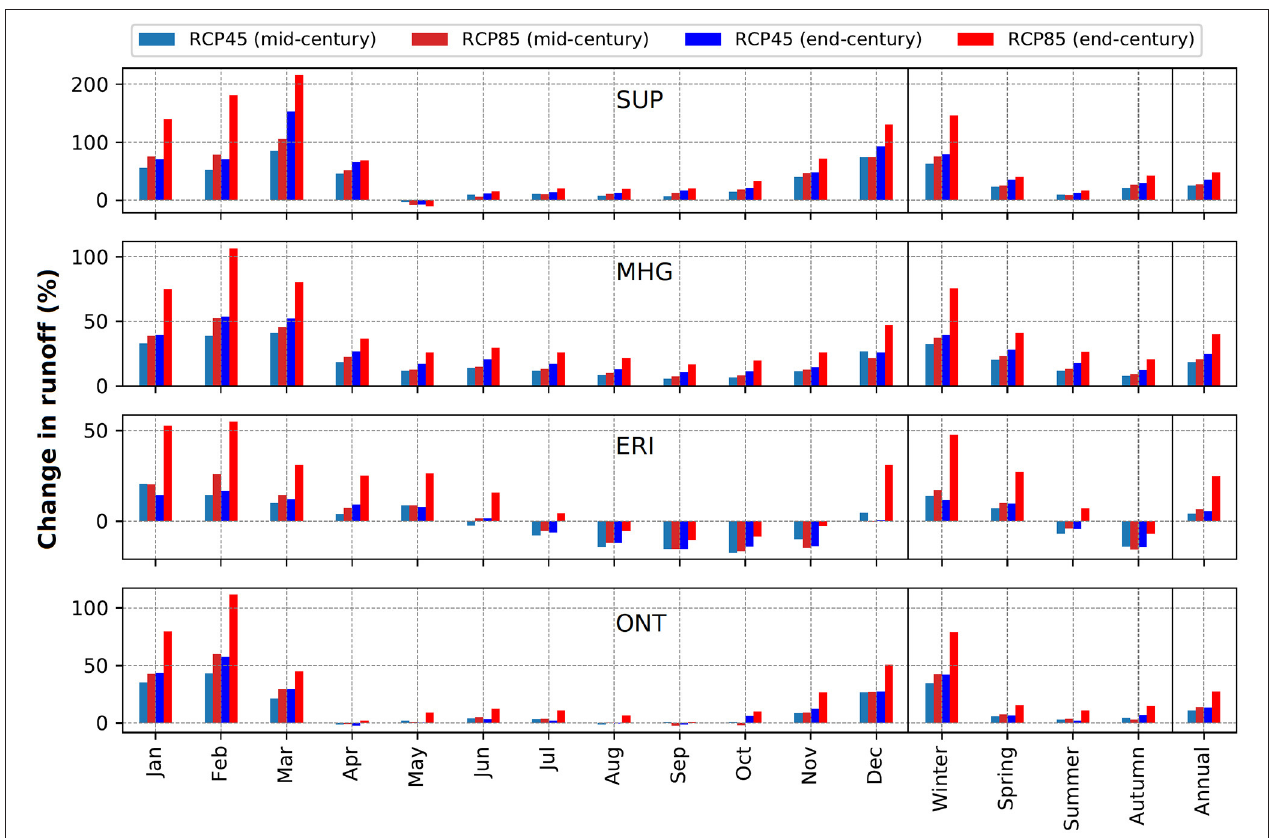
FIGURE 14 | Change in monthly, seasonal, and annual runoff with respect to the baseline values for RCP4.5 and RCP8.5 scenarios in both mid- and end-century